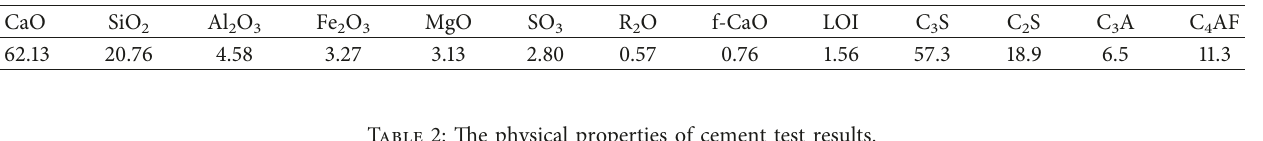
Table 1: The chemical compositions and mineral compositions of cement wt%.